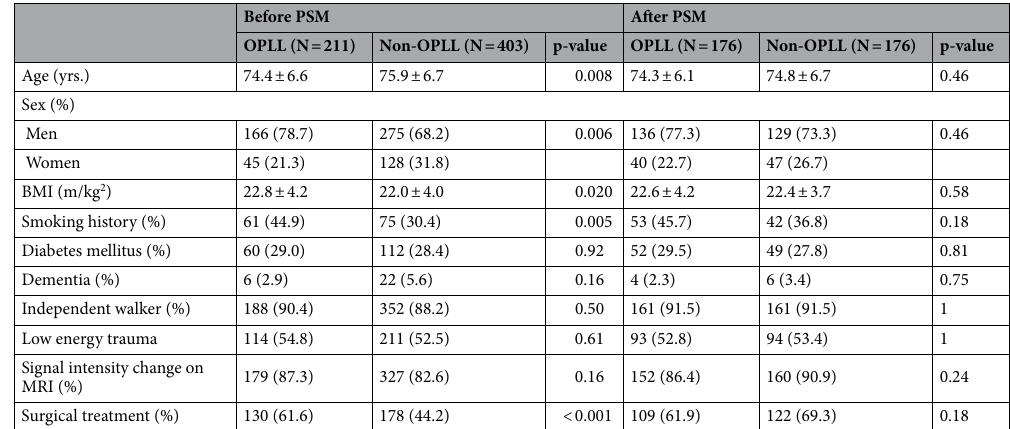
Table 5. Patient demographics in cervical spinal cord injury without bone injury. PSM, propensity score matching; BMI, body mass index; MRI, magnetic resonance imaging; and OPLL, ossification of the posterior longitudinal ligament.